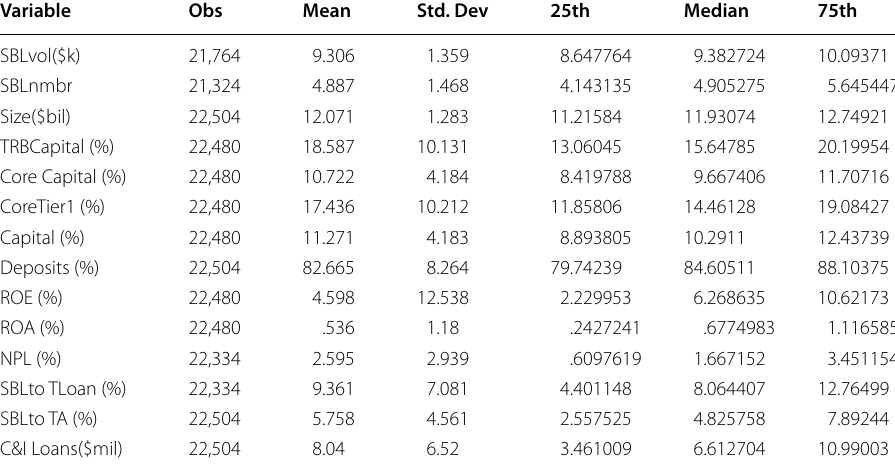
Table 2 Descriptive statistics of bank